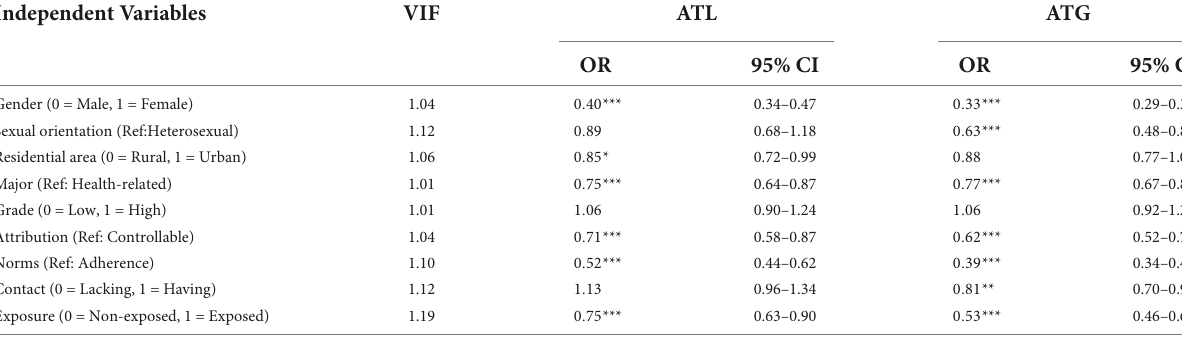
TABLE 6 Logistic regression analyses of factors associated with ATL and ATG ( n = 6,036). Independent Variables VIF ATL ATG OR 95%